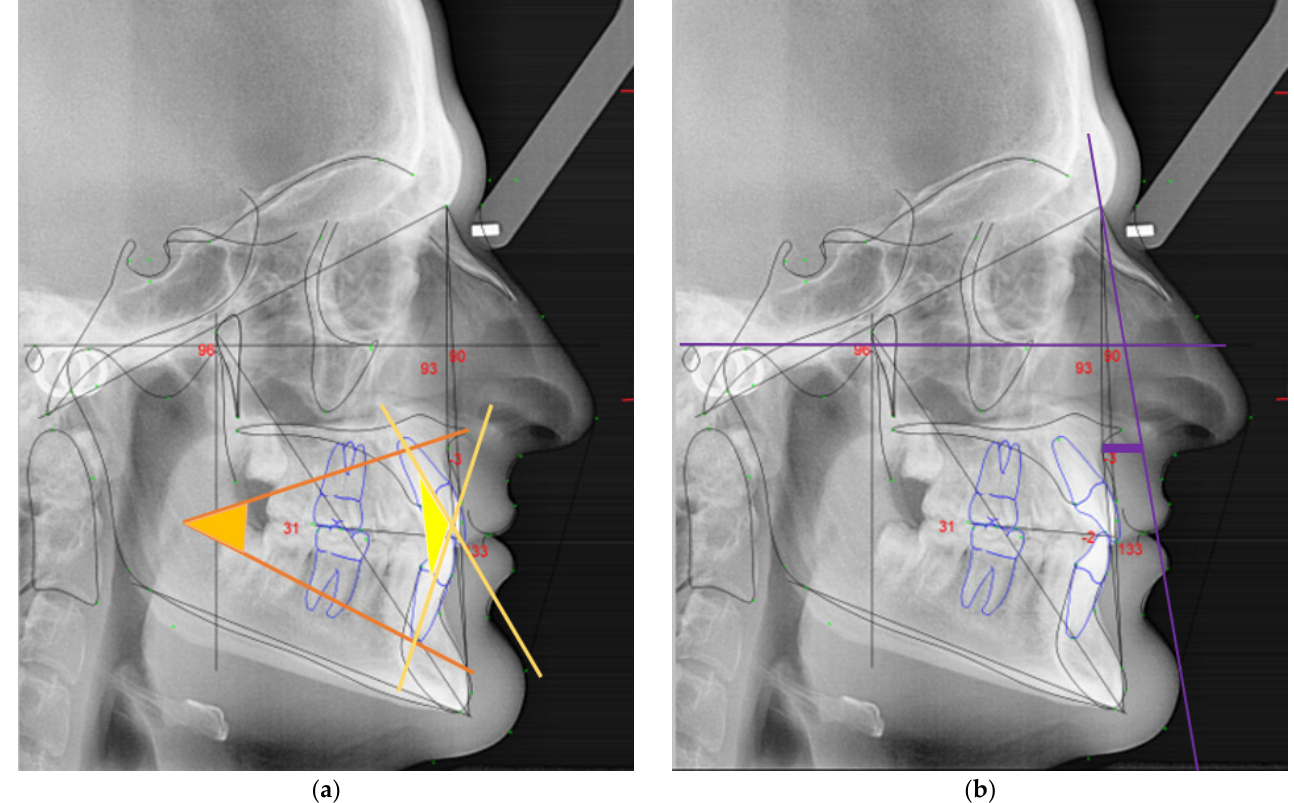
Figure 2. Rickett’s cephalometric analysis with specific parameters analyzed: ( a ) lower facial angle (orange) and interincisal angle (yellow); ( b ) facial convexity (purple).